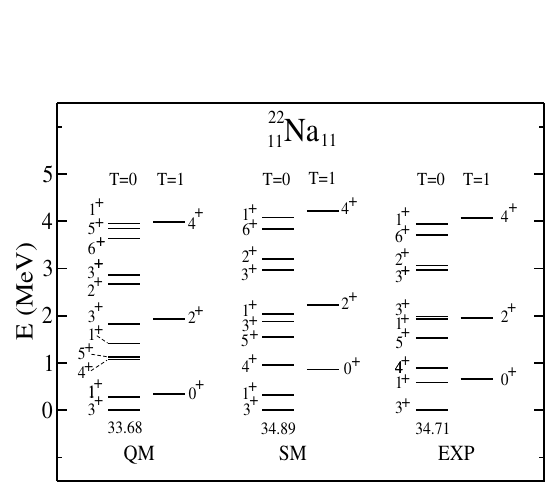
Figure 3. The spectrum of 22 Na obtained with the quartet for- malism (QM) compared with shell model (SM) and experimental (EXP) spectra. The number below each spectrum is the ground state correlation energy (see Fig. 1).